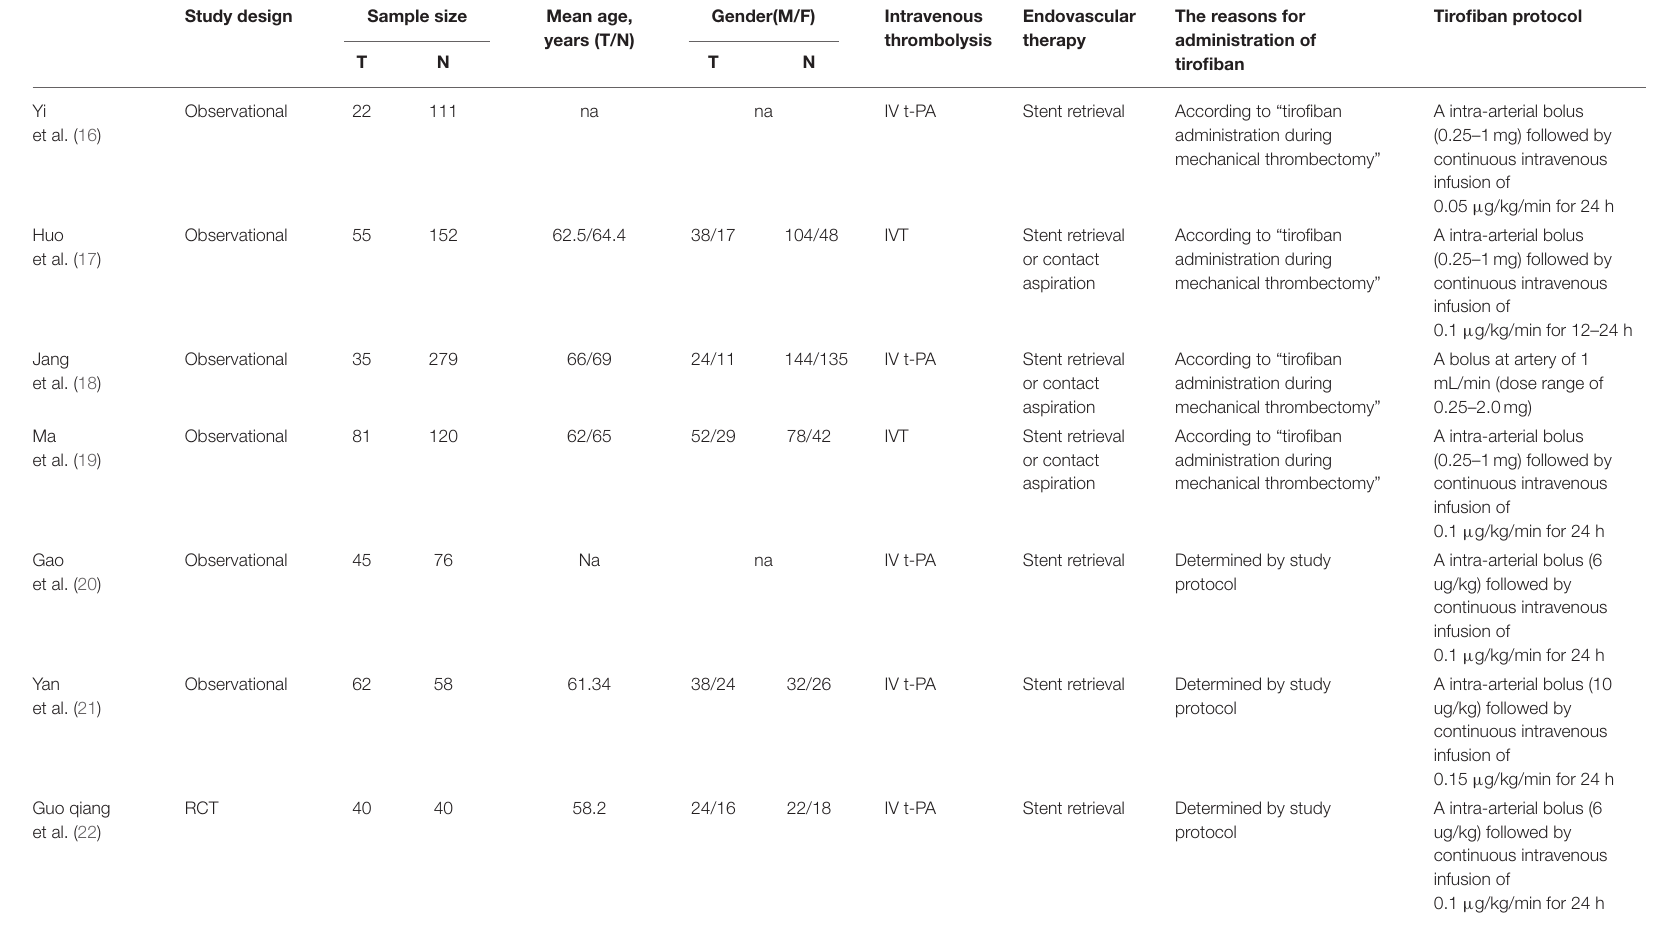
TABLE 1 | Basic characteristics of the included